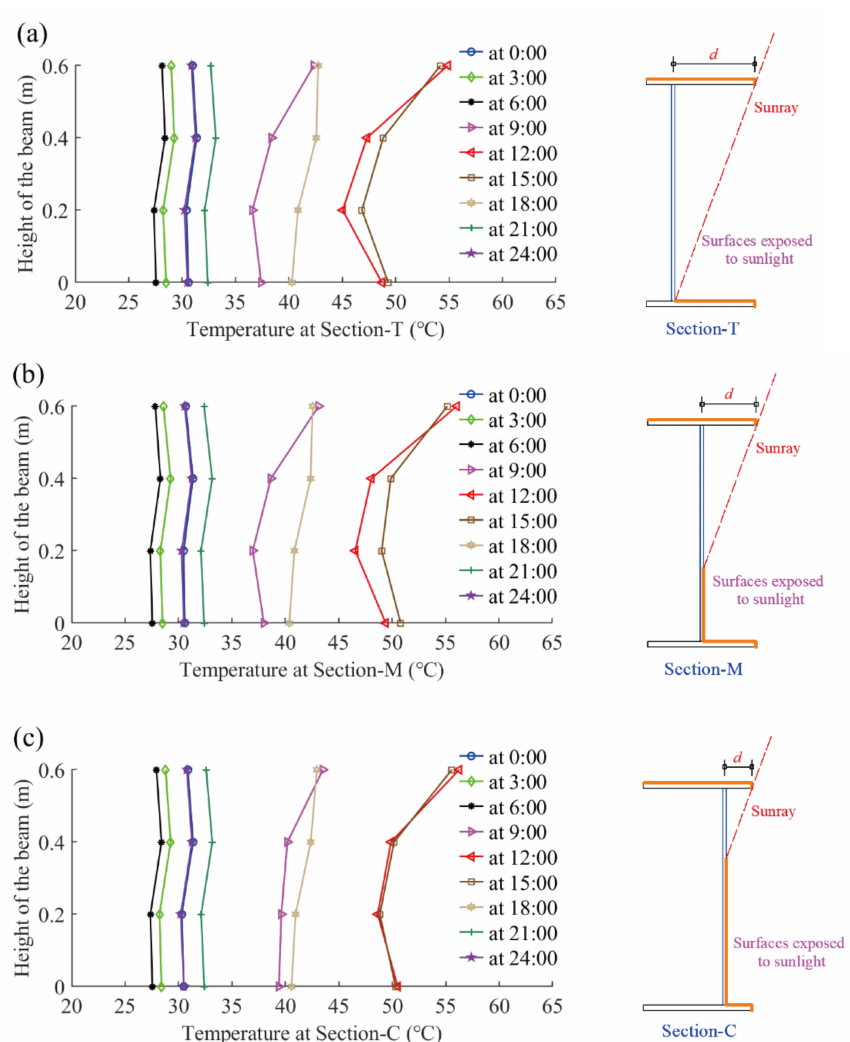
Figure 6. Vertical temperature distributions of the steel beam: ( a ) Section-T; ( b ) Section-M; and ( c ) Section-C.